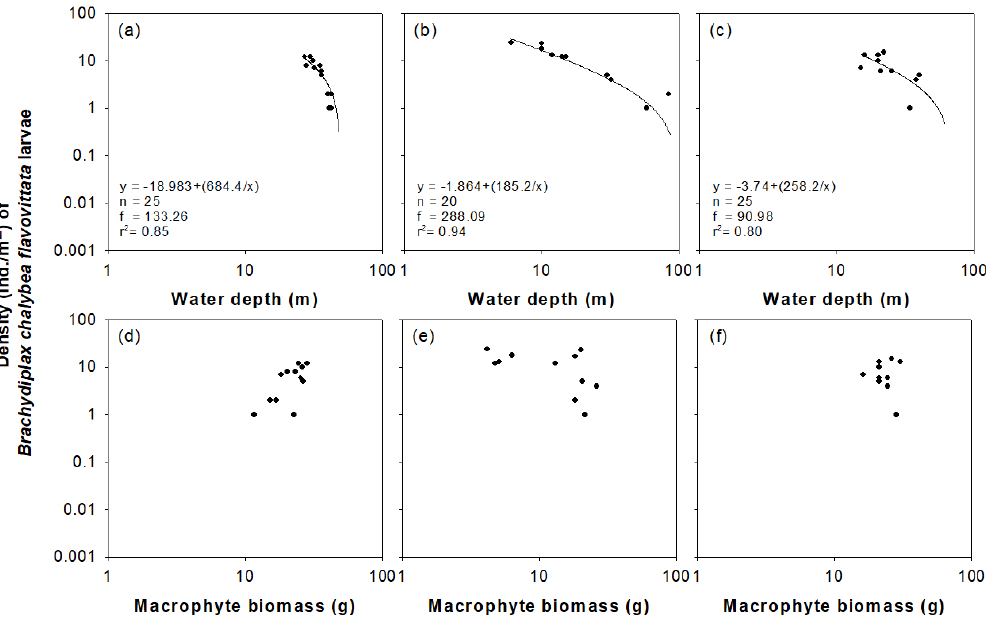
Figure 6. The relationships between the density of Brachydiplax chalybea flavovittata larvae and water depth at sites 1, 5, and 14 (a, b, and c), and with macrophyte biomass at sites 1, 5, and 14 (d, e, and f).